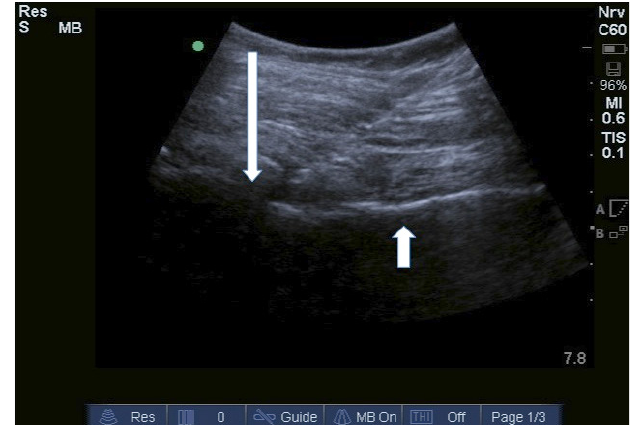
Figure 2 . Real-time ultrasound view of needle insertion. The needle tip in the anterior synovial recess just distal to the femoral head is indicated with the long arrow. The femoral neck identified is indicated with the shorter arrow.